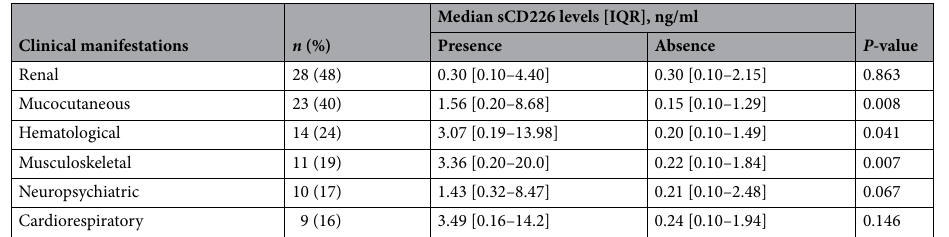
Table 2. Serum sCD226 levels in SLE patients with each clinical manifestation. Serum sCD226 levels were compared between SLE patients with each clinical manifestation and those without. The table lists the clinical manifestation that occurred in more than 10% of patients. Statistical differences among groups were evaluated using the Mann–Whitney U test. sCD226 soluble CD226, SLE systemic lupus erythematosus, IQR interquartile